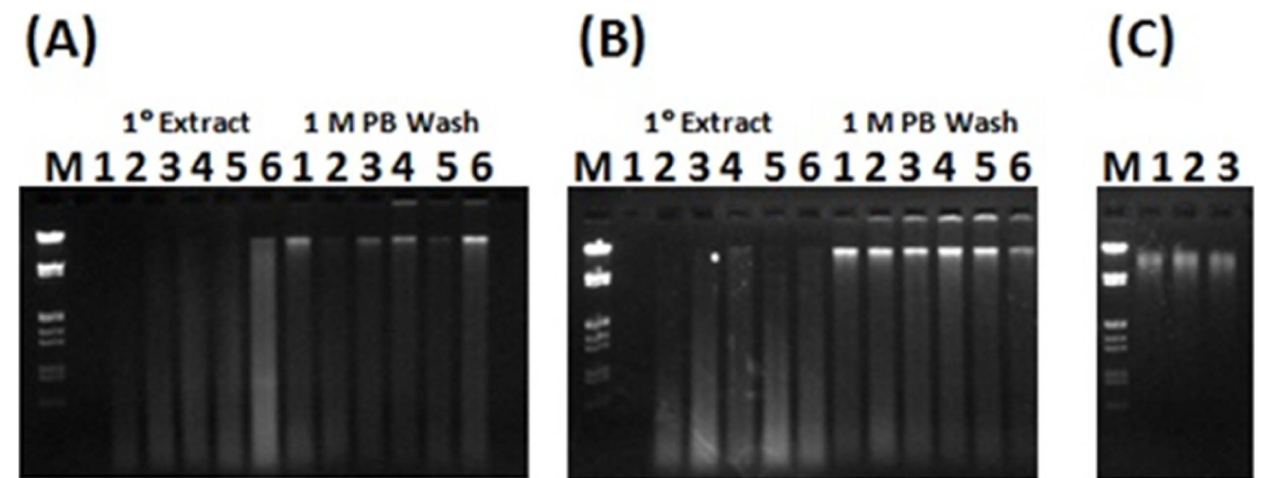
Figure 3. Phosphate gradient test. ( A ) 1 u extract. 1.2% agarose gel using 0.1 m g/ml ethidium bromide in 1 6 TAE at 3 V/cm for 90 min. Lanes 1–6 (1 u extract); 0, 100 mM PB, 200 mM PB, 300 mM PB, 400 mM PB, and 500 mM PB in the lysis reagent respectively. Ten percent of the total yield from the initial extraction process from 200 mg wet weight of the iron oxide cemented clay environment electrophoresed in each lane. 1 M PB Wash. Lanes 1–6 show the results of a re-wash of the sedimented clay pellets from the 1 u extraction process with 1 M sodium phosphate buffer (pH 7.2). Ten percent of the total yield from the 1 M PB clay pellet re-wash was electrophoresed. Lane M; Marker III (Roche). ( B ) Second of three replicate extraction sets electrophoresed as given for ( A ) showing the extent of set to set variability. ( C ) 1.2% agarose gel using 0.1 m g/ml ethidium bromide in 1 6 TAE at 4.7 V/cm for 90 min. Lanes 1–3; replicate extractions from 250 mg samples of the iron oxide cemented clay using the Powerlyzer, PowerSoil H DNA isolation kit (MoBio); 10% of the total yield. Lane M; Marker III